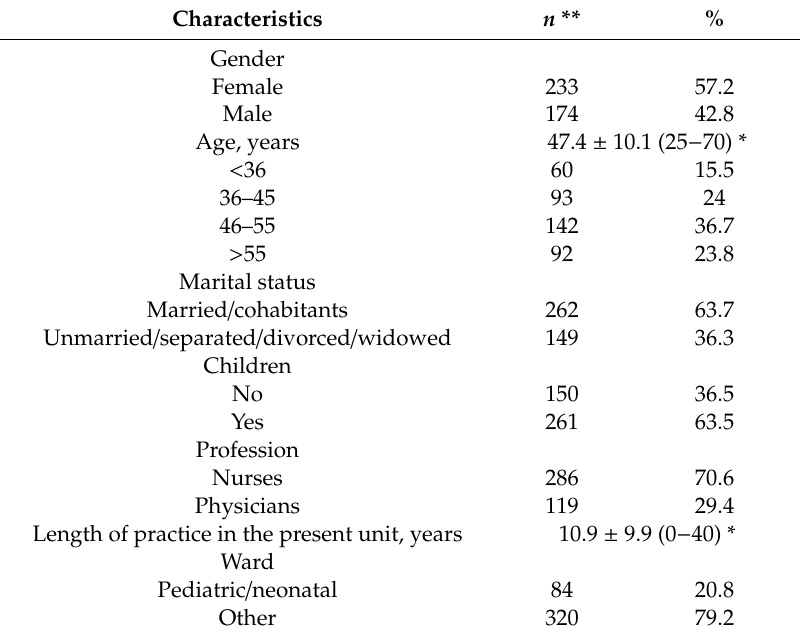
Table 1. Participants’ socio-demographic and professional